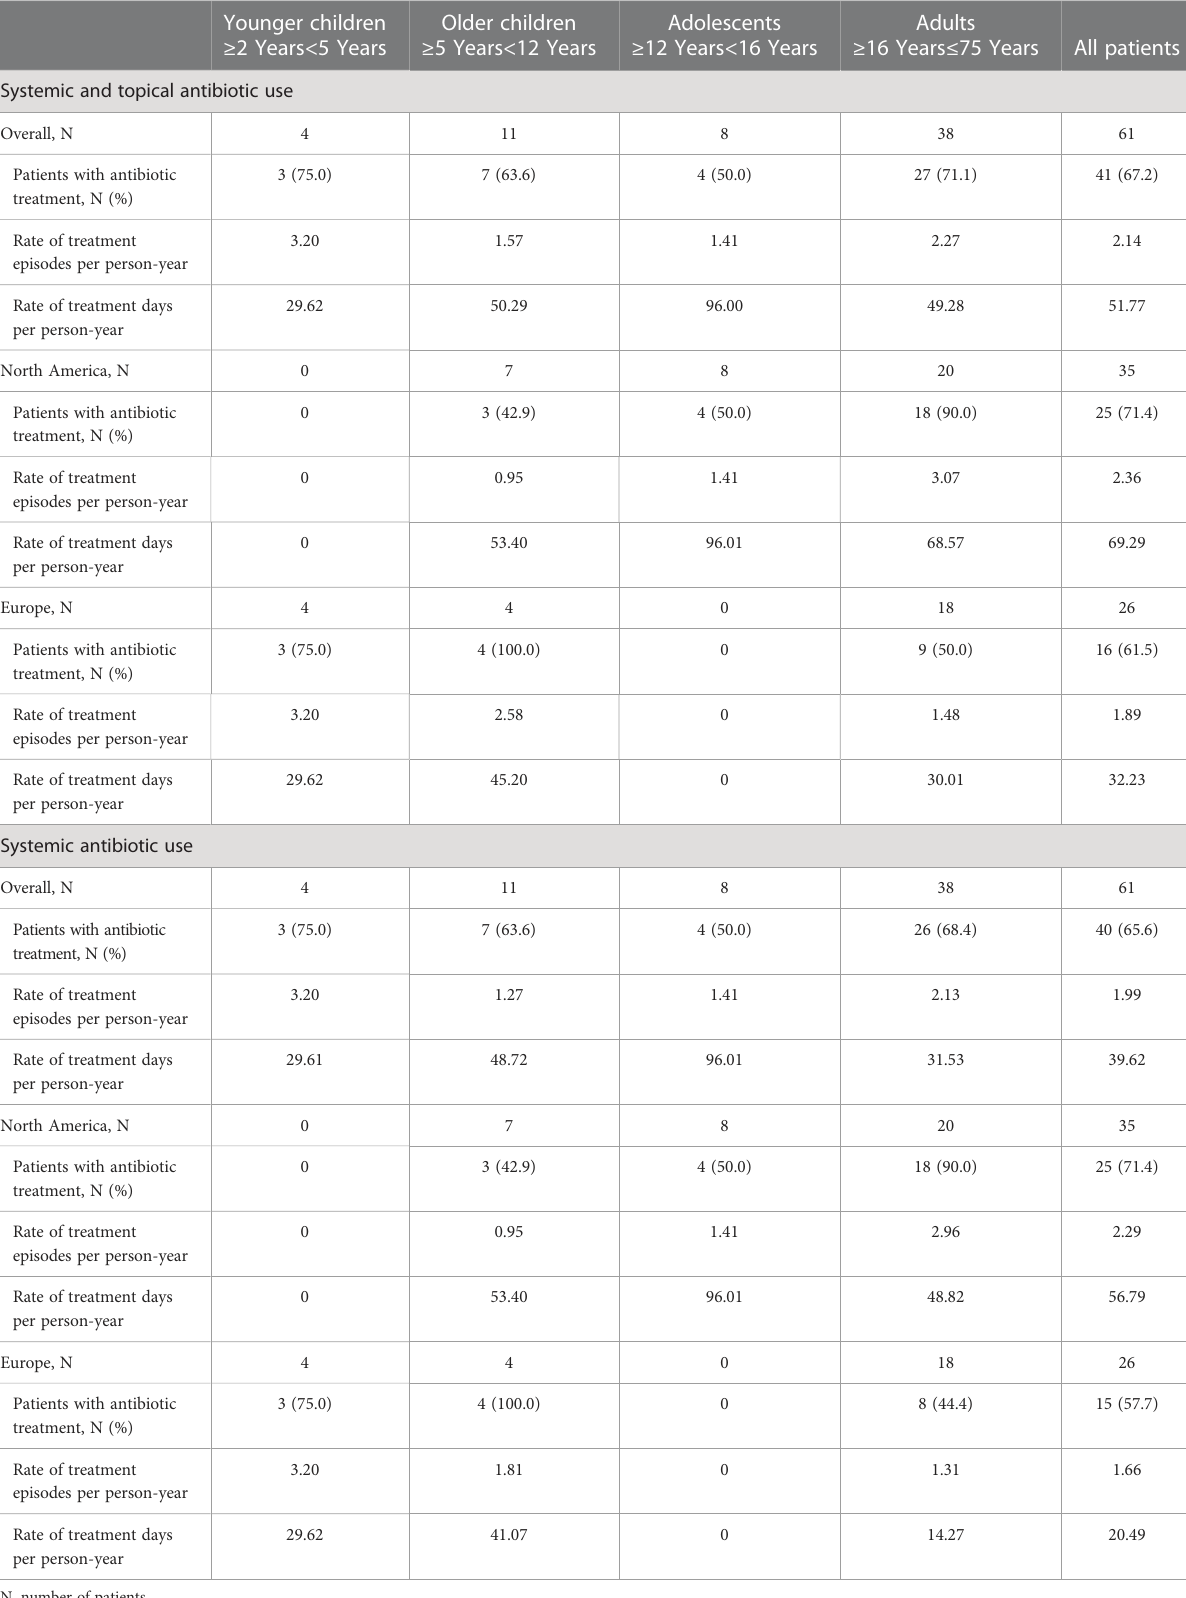
TABLE 4 Systemic and topical antibiotic use, overall and by